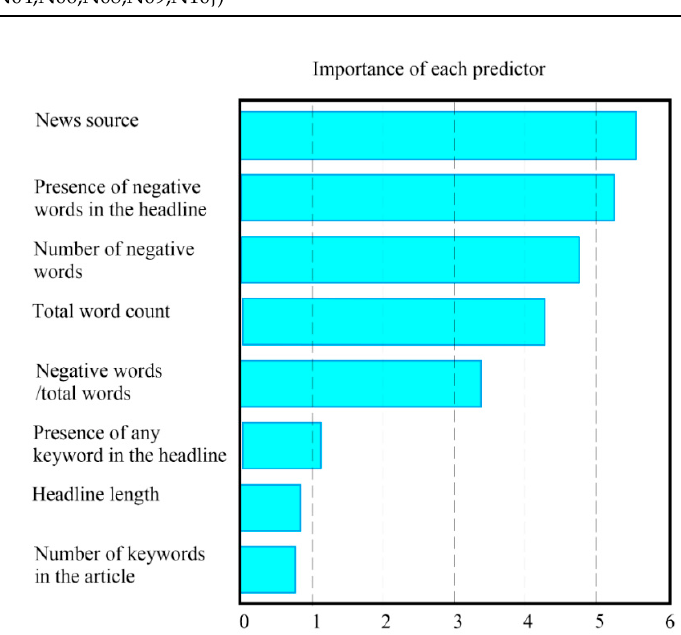
ff ect of each variable on abnormal Figure 13. Random forest analysis of the effect of each variable on abnormal returns. Figure 13. Random forest analysis of the e